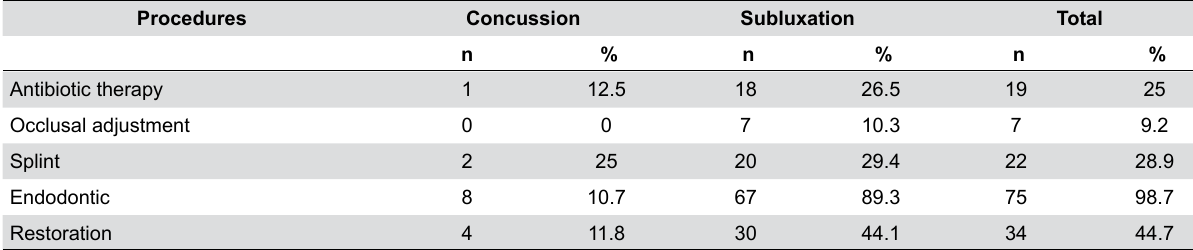
Table 6- Descriptive distribution of procedures performed in cases of concussion and subluxation